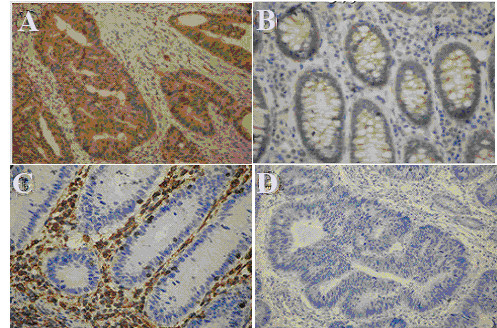
Representative images of immunohistochemical staining to detect the expression of AQP5 and AQP8 in clinical colorectal samples. (A) AQP5 immunoreactivity was detected in the cytoplasm and plasma membrane of colorectal carcinoma cells (dark brown). (B) AQP5 immunoreactivity was not detected in the adjacent normal colon epithelium. (C) AQP8 immunoreactivity was detected in the cytoplasm and plasma membrane of adjacent normal colon epithelium (dark brown). (D) AQP8 immunoreactivity was not detected in the colorectal carcinoma tissues. (Magnification: ×400).